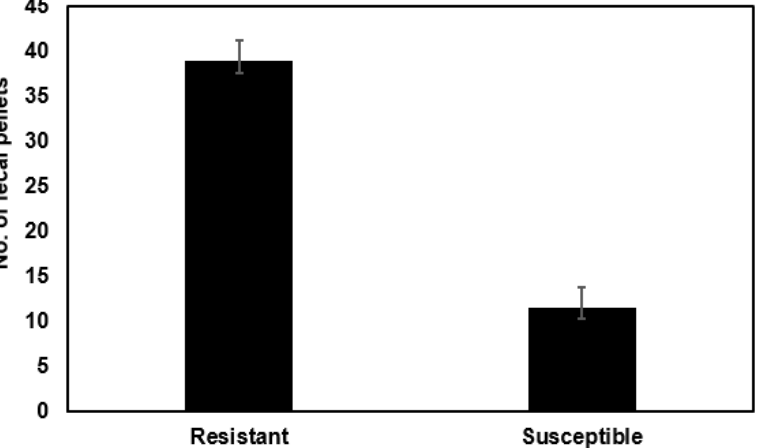
Figure 5. Fecal production over 24 h of Cry1Ac-susceptible Spodoptera frugiperda neonates versus Cry1Ac resistant S. frugiperda neonates on artificial diet containing no Bt toxins (using the feeding disruption assay; n = 80 for each treatment). Error bars are ±1 standard error of the mean.